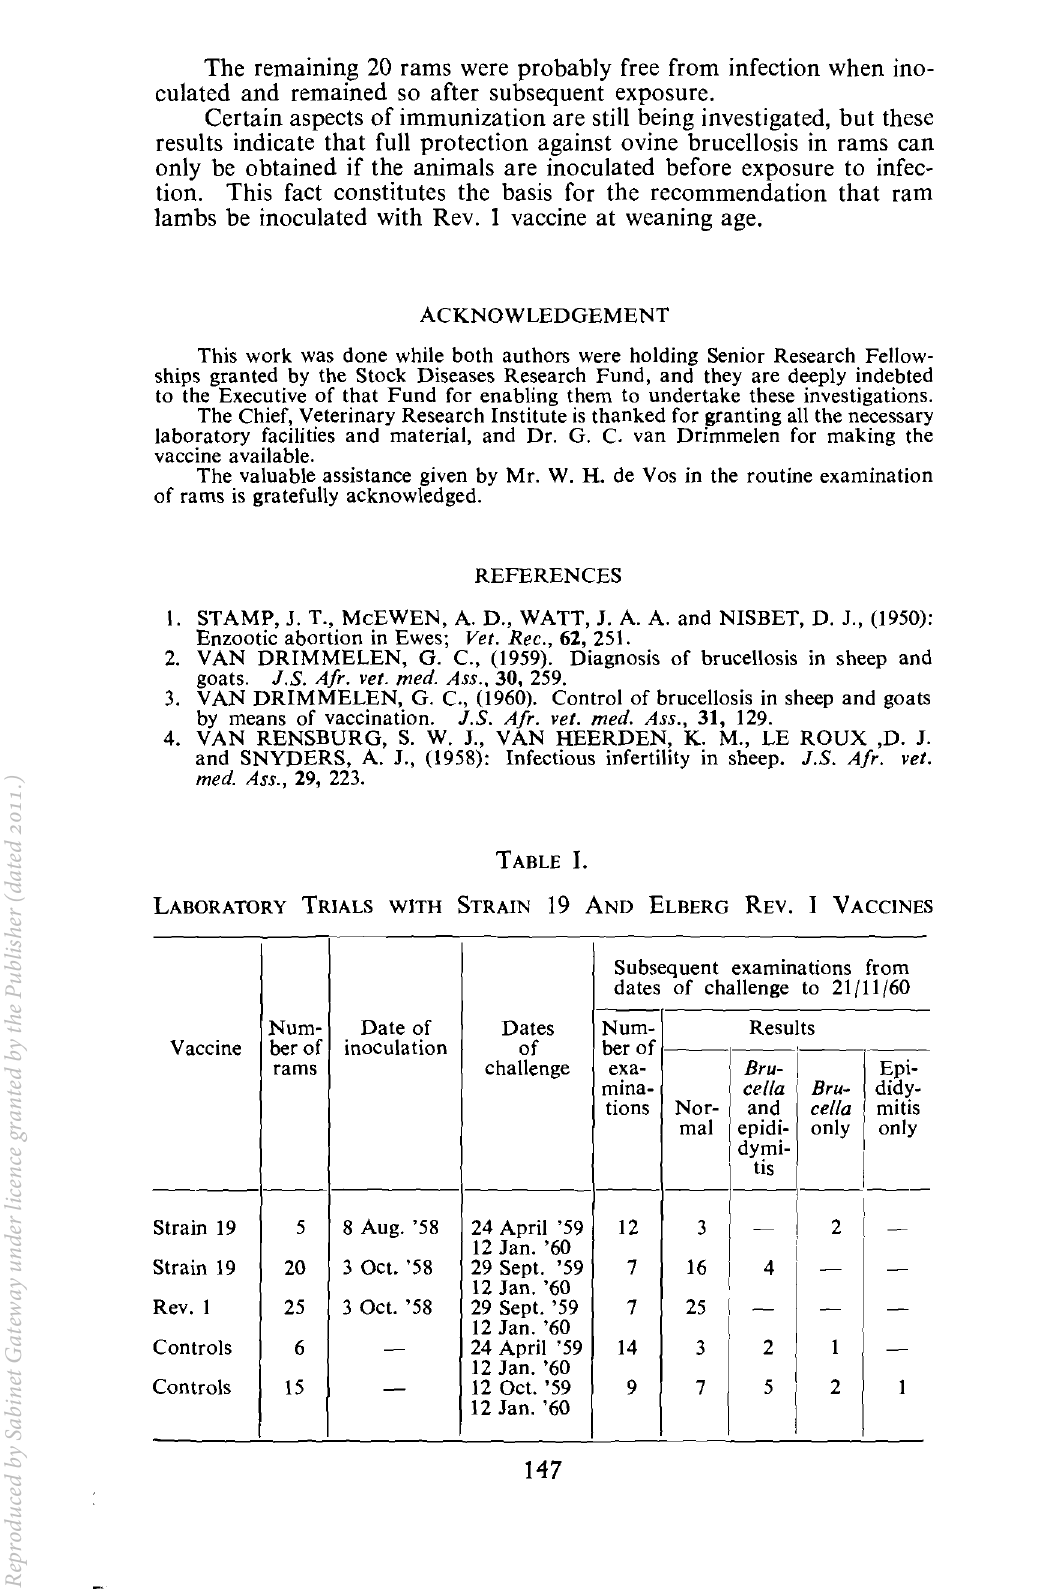
Subsequent examinations from dates of challenge to